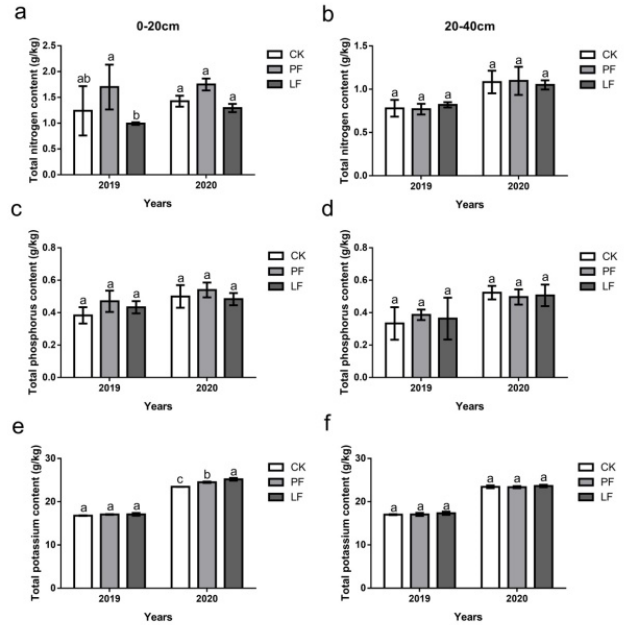
Figure 3. Effects of in-row mulching on the total nutrients of the soil in 2019 and 2020. ( a ): Total nitrogen content (0–20 cm); ( b ): Total nitrogen content (20–40 cm); ( c ): Total phosphorus content (0–20 cm); ( d ): Total phosphorus content (20–40 cm); ( e ): Total potassium content (0–20 cm); ( f ): Total potassium content (20–40 cm). Notes: Values are the mean ± SD of three biological replicates. Different letters above the columns indicate significant differences between treatments in Duncan’s multiple comparisons ( p < 0.05).